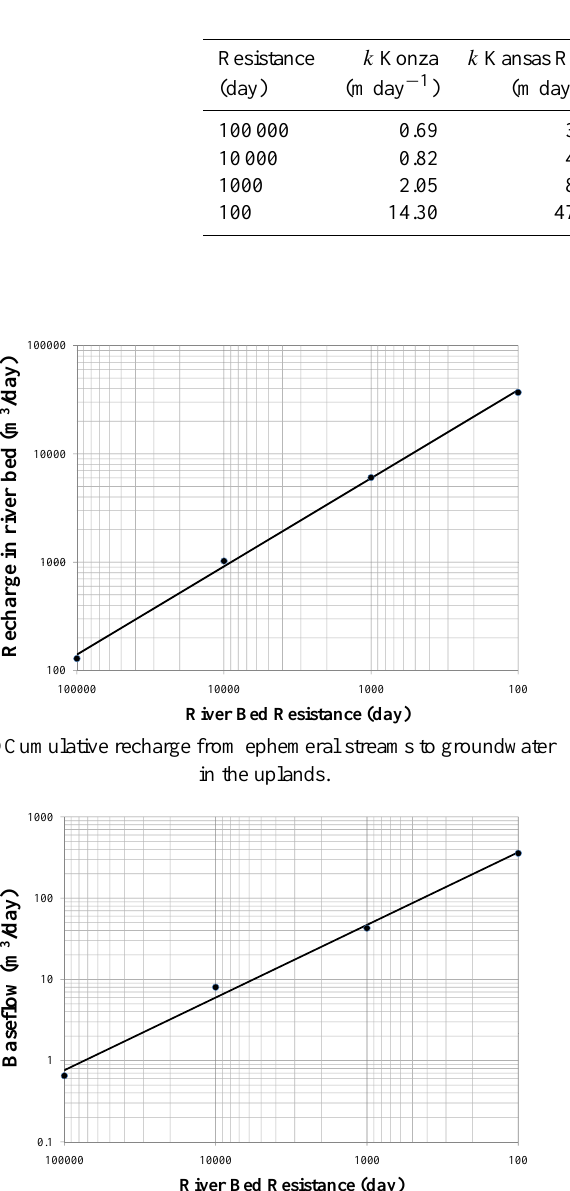
Table 4. Groundwater parameter estimation.